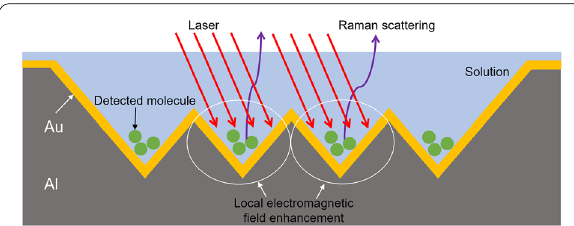
Figure 2 Schematic of Raman detection principle for Au-Al ordered micro/nanostructure substrate obtained based on nanoindentation process